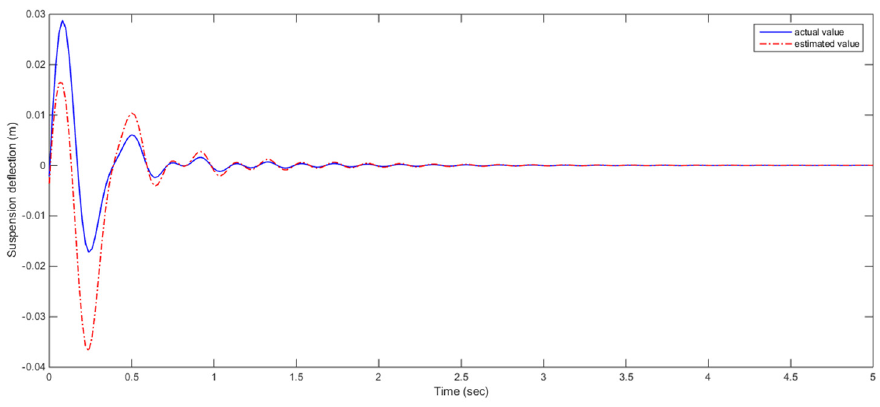
Figure 4. The step response of the actual and estimated suspension deflection.